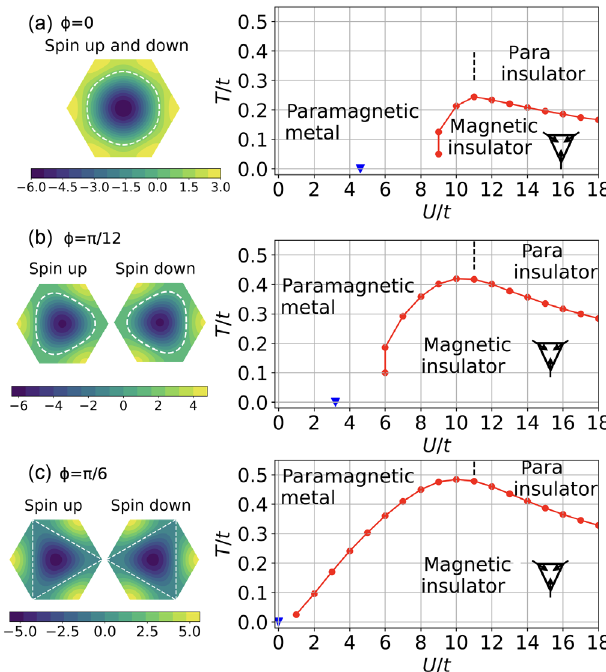
FIG. 1. DMFT phase diagram at half filling for (a) ϕ ¼ 0 , (b) π = 12 , and (c) π = 6 . The red lines represent the phase boundary between the magnetic state and the paramagnetic state, deter- mined by the Landau theory. The black dashed line indicates the paramagnetic insulator transition, with resolution Δ U ¼ t , Δ T ¼ 0 . 1 t . The blue triangle marks the transition at zero temper- ature from the Hartree-Fock calculation. On the left, we also show the isoenergy dispersion contours at zero interaction, where the dashed lines mark the Fermi surface at half